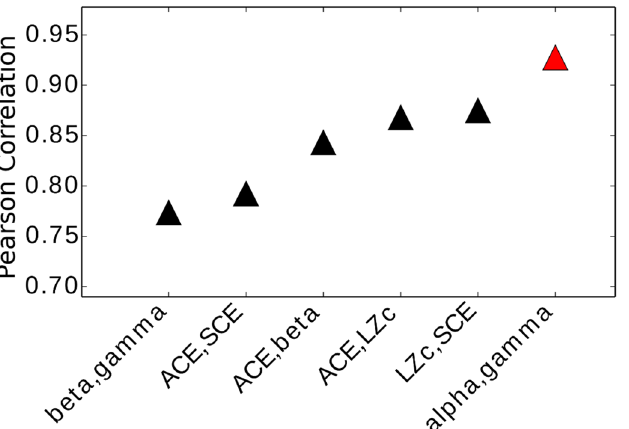
Fig 9. Pearson correlations between measures. Each black triangle indicates the positive correlation for the given measure pair listed in increasing order along the x-axis. The correlation was computed across subjects for the ratio of WR/LOC. Each correlation of all possible pairs of 9 measures was tested for significance and only those with 2-tailed p -value smaller than 0.05 are plotted. The red triangle indicates negative correlation. All 3 pairs out of ACE, LZc, SCE correlate significantly. There is no significant correlation of delta power with any other of the 9 measures for the state pair